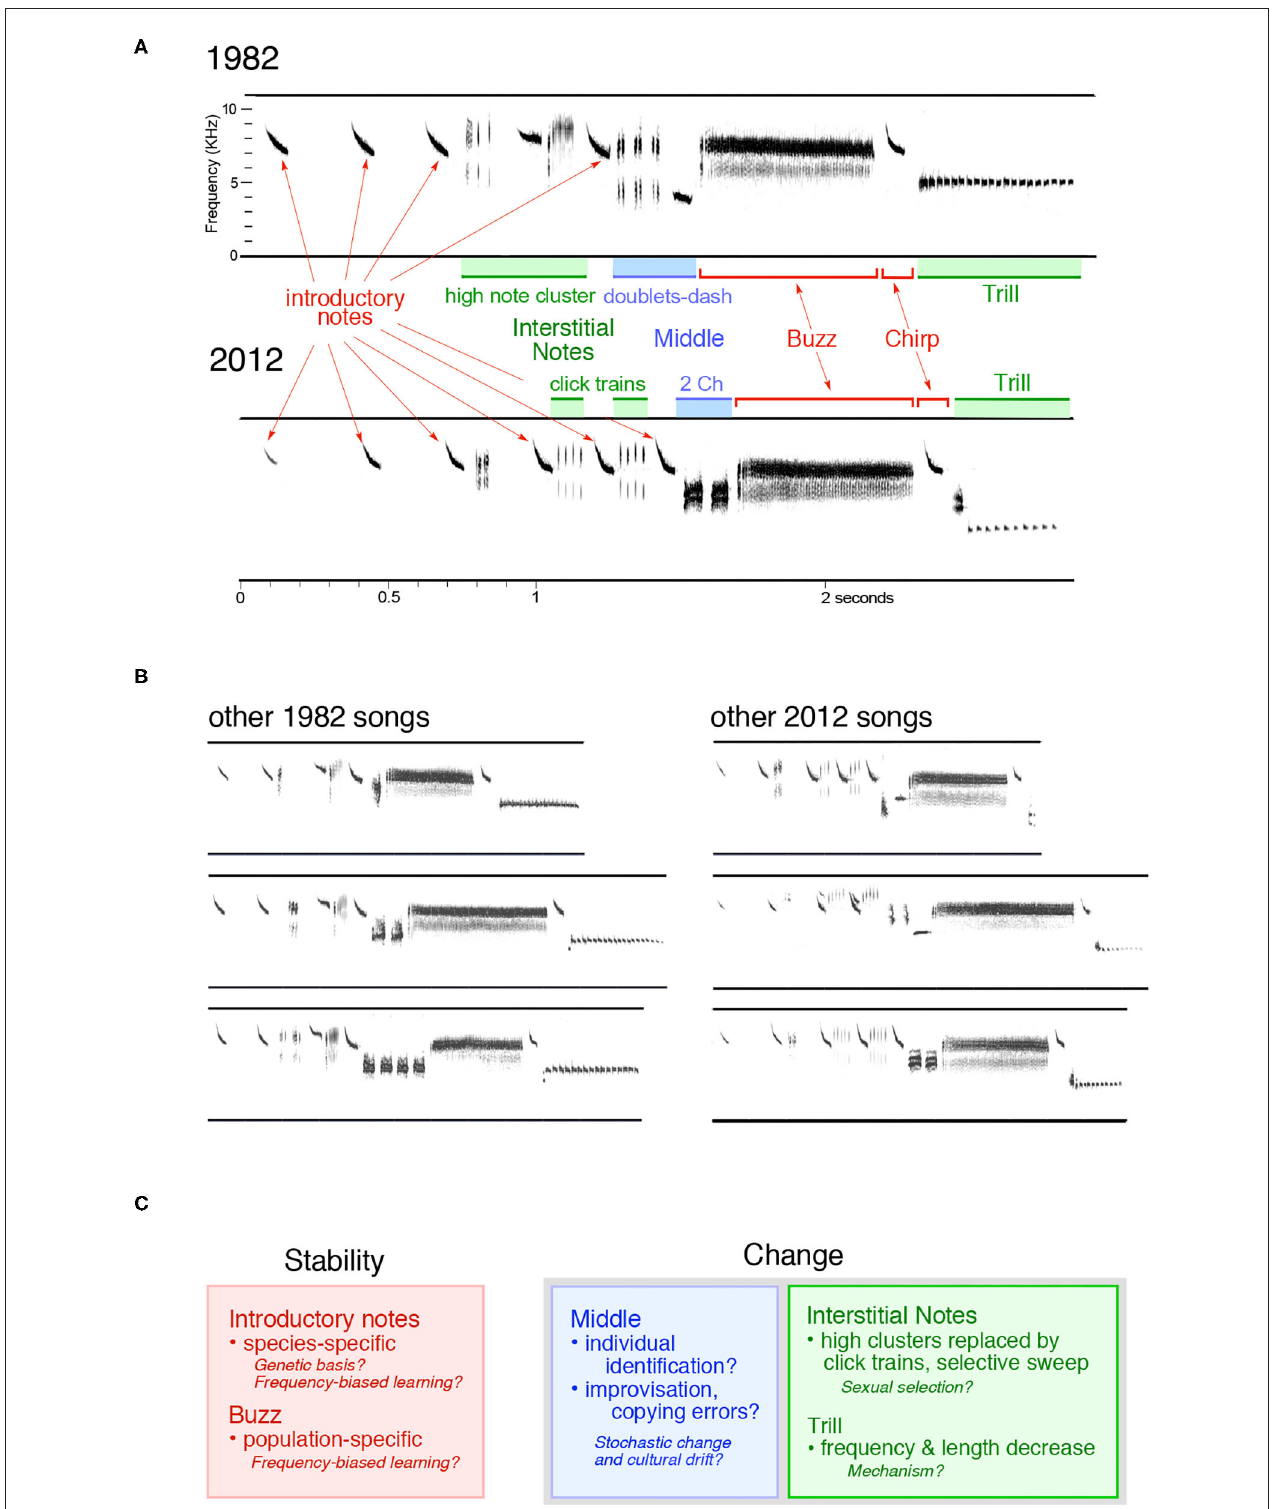
FIGURE 1 | Cultural evolution in a Savannah sparrow population. (A) The two songs shown here, recorded 30 years apart, include the most common types of interstitial notes and middle notes sung in their respective years. Although some individual variation exists, introductory notes, buzzes and chirps (which match the introductory notes in this population) had stable acoustic characteristics, while interstitial notes, middle segments, and trills changed over time. (B) Additional examples of songs sung in 1982 and 2012 (initial introductory notes were omitted from some songs shown here). (C) The direction of song changes and possible explanations are summarized; no single mechanism can account for the cultural evolution observed in the songs of this population.